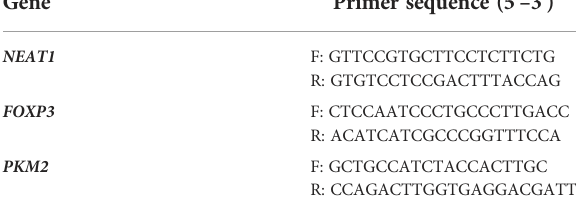
Table 1. The 2 − DD Ct quantitative method was used to calculate the relative expression of the genes.